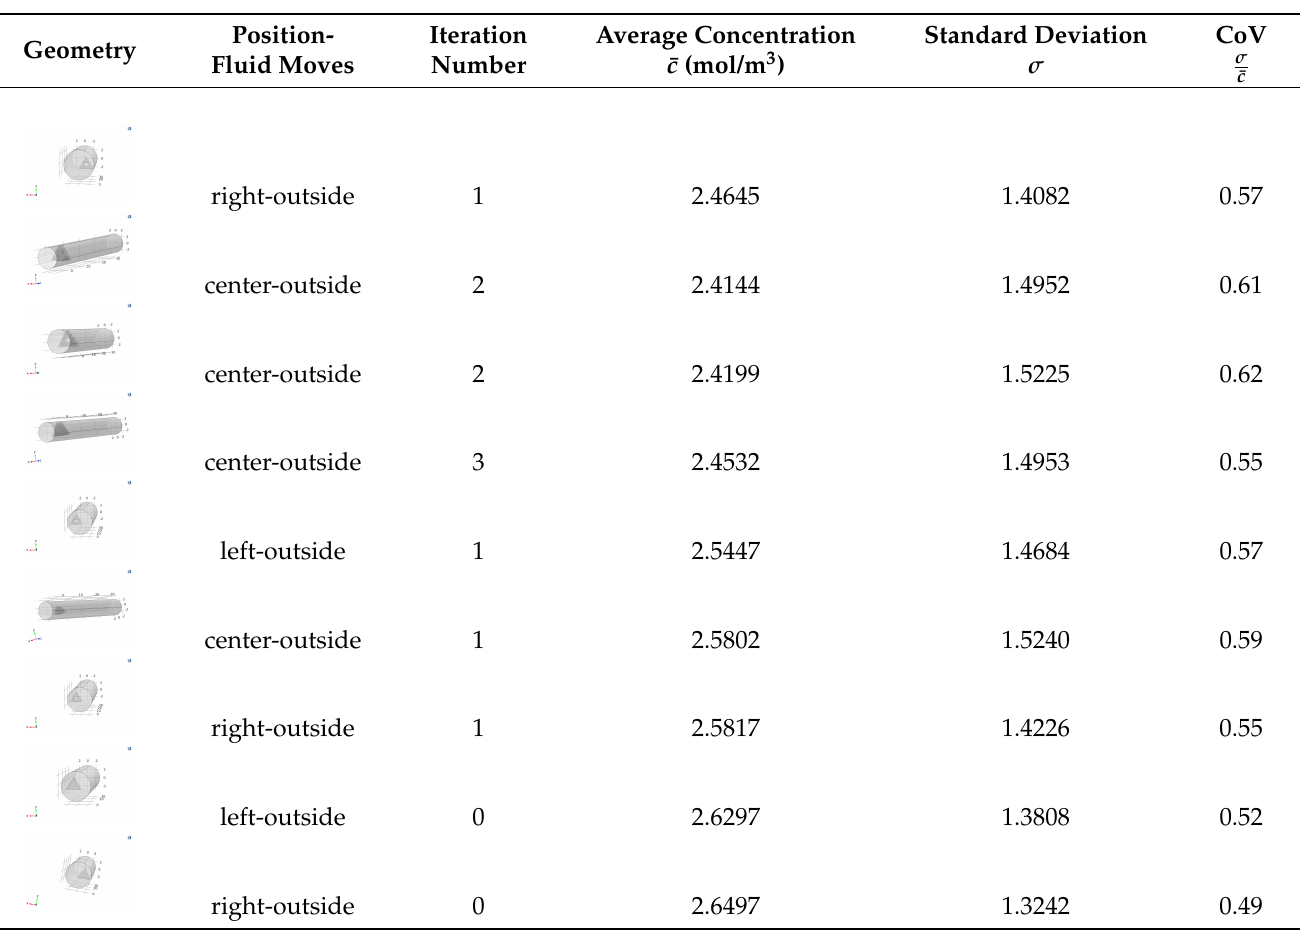
Table 2. Values of CoV, which indicates the quality of mixing the two fluids using Sierpinski triangle patterns and obstacles with circular cross-section.